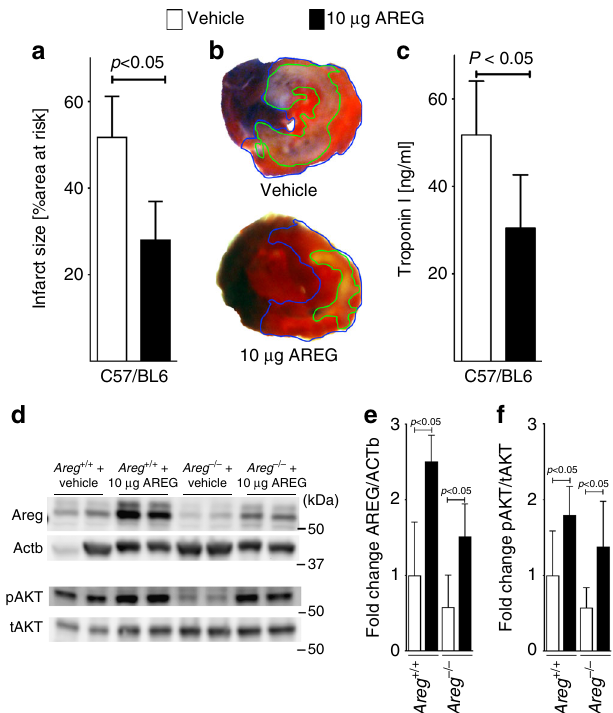
Fig. 7 Treatment of murine myocardial ischemia and reperfusion injury with recombinant amphiregulin. a – c Wild-type were exposed to 60 min of myocardial ischemia, followed by 120 min of reperfusion; infarct sizes were measured by double staining with Evan ’ s blue and triphenyltetrazolium chloride and serum samples were collected. All Infarct sizes are presented as the percentage of infarcted tissue in relation to the area-at-risk. Serum troponin levels were determined by ELISA. a Infarct sizes of C57/BL6 mice after 60 min of ischemia and 120 min reperfusion, treated with vehicle or 10 µ g recombinant murine AREG, administered over a 15 min period via an indwelling arterial catheter. Data presented are the percentage of infarcted area in relation to area-at-risk. Statistical signi fi cance assessed by two- sided, unpaired Student ’ s t -test ( n = 7 per group; data presented as mean ± SD). b Representative infarct staining of C57/BL6 treated with vehicle or 10 µ g recombinant murine AREG. c Serum troponin levels of C57/BL6 mice, after 60 min ischemia, 120 min reperfusion, treated with vehicle or 10 µ g recombinant murine Areg. Statistical signi fi cance assessed by two-sided, unpaired Student ’ s t -test ( n = 5 per group; data presented as mean ± SD). d Areg + / + or Areg − / − mice received treatment with vehicle or 10 μ g of recombinant murine AREG, administered over a 15 min period by an indwelling catheter. The animals underwent 60 min ischemia and 120 min reperfusion, followed by total protein isolation form the area-at-risk. Upper panel: protein was immunoblotted for AREG, β -actin (ACTb) served as a loading control. Lower panel: protein was immunoblotted for total AKT (tAKT) and phosphorylated AKT (pAKT), respectively. Two samples for each condition and genotype are presented. One representative blot out of three experiments is shown. e , f Quanti fi cation by densitometry of the AREG and pAKT immunoblot results relative to ACTb or Total AKT (tAKT). Data are expressed as mean fold change ± SD normalized to vehicle treated Areg + / + and compared by one-way ANOVA followed by Bonferroni ’ s multiple comparison test ( Areg + / + +Vehicle n = 5; all other groups n = 6 mice per group, e F 3,19 = 23,11, p < 0.0001; f F 3,20 = 9,549, p =